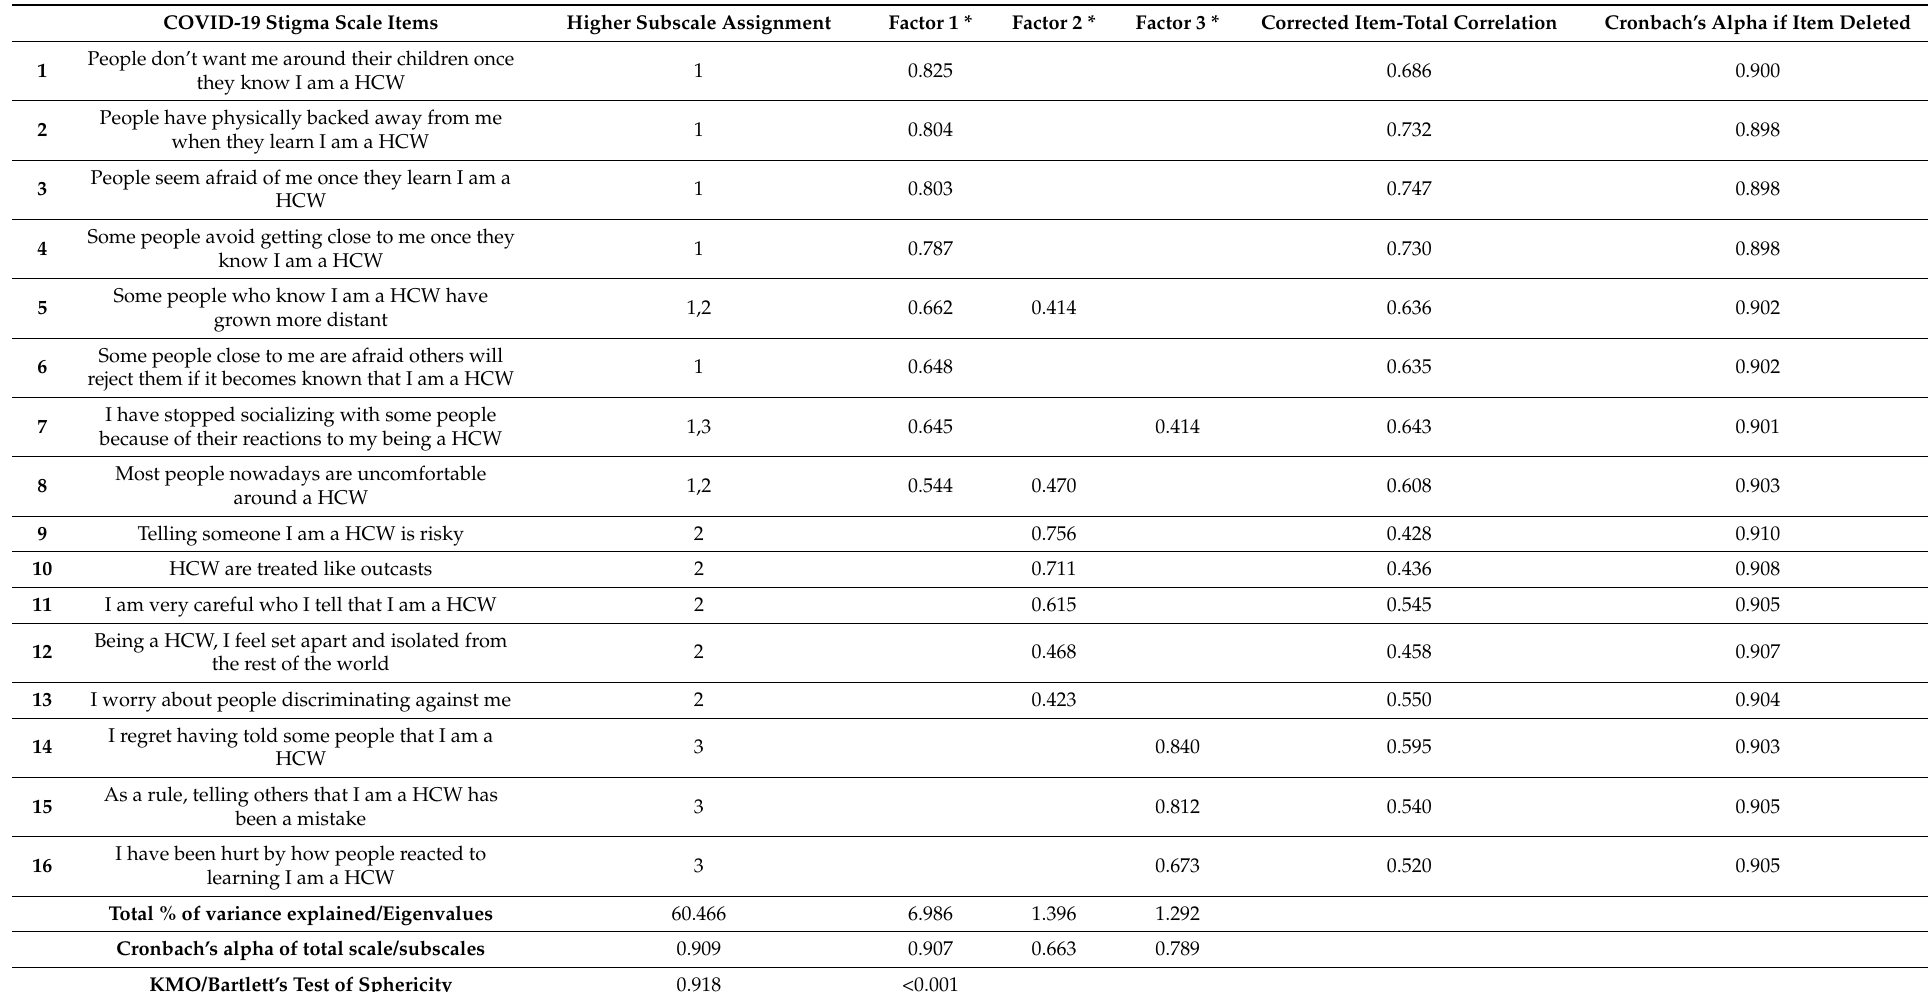
Table 2. Exploratory factor analysis of the adapted COVID-19 stigma scale among one half of the sample of Egyptian physicians (n =